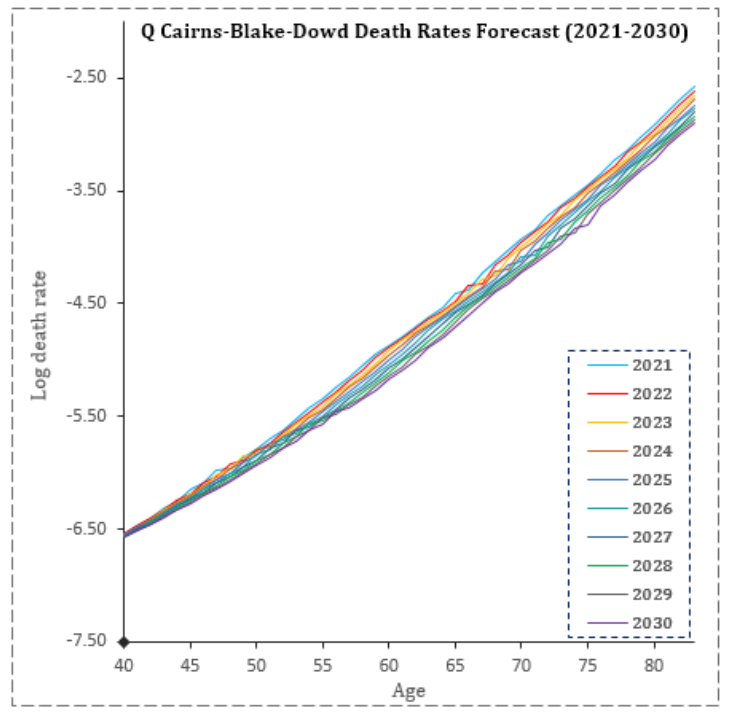
Figure A4. Quadratic Cairns–Blake–Dowd Rate Forecast for Period